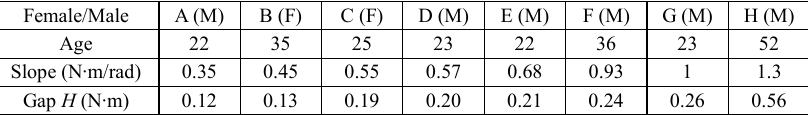
Table 1 Average parameter of slave’s arm within range of R